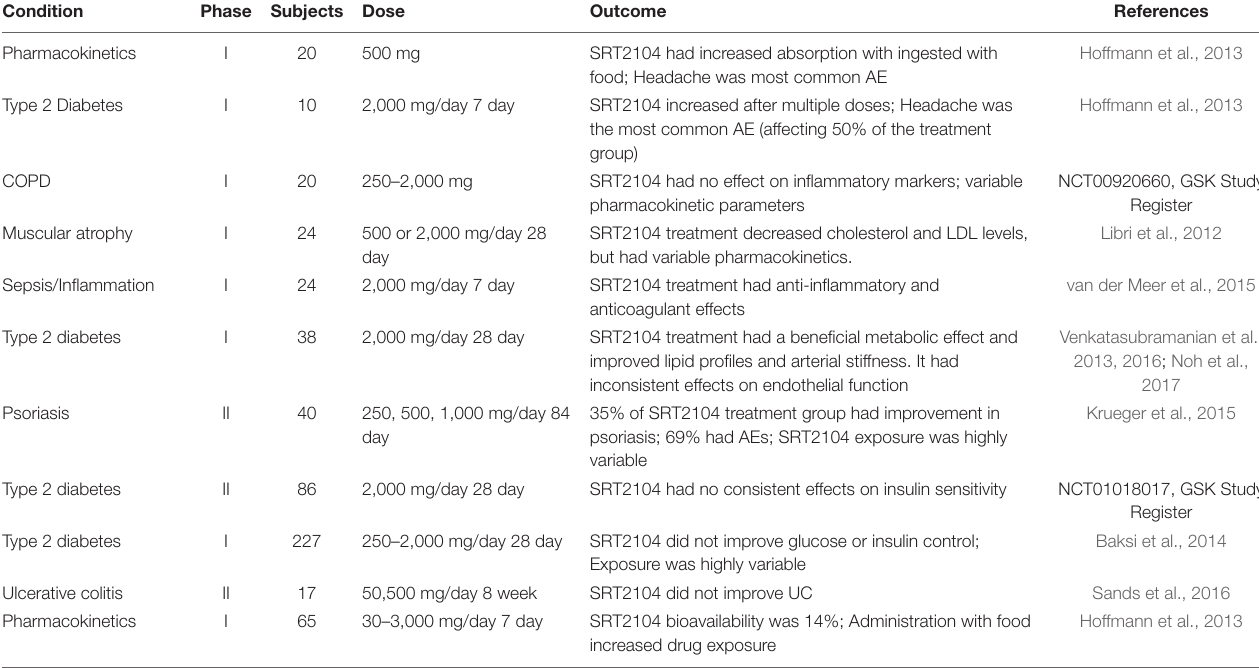
TABLE 10 | Clinical trials on SRT2104.